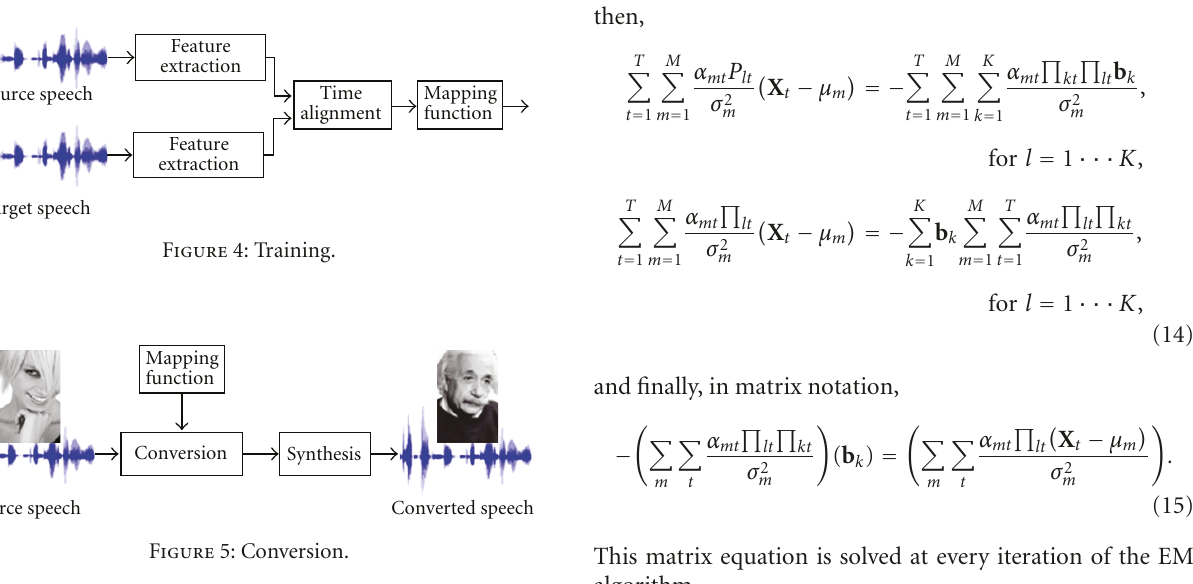
Ma pp in g functionTime